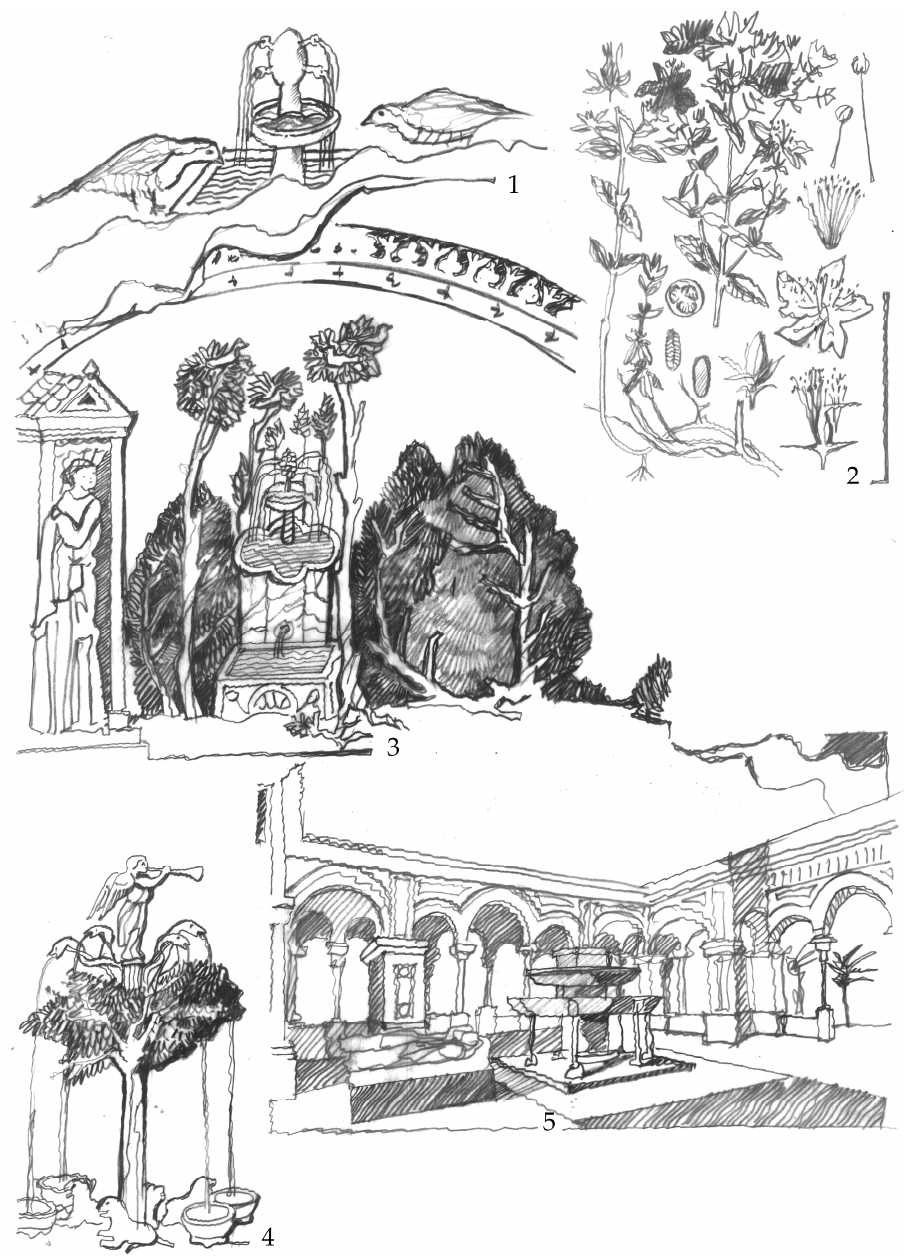
Figure 2. 1 and 3 —‘ Fountains… enclosed parts to irrigate’ ; 2 —‘ and out of Egypt the red St. John’s wort they brought ’; 4 — ‘ lions, leopards and eagles, partridges and fairies springing out of their mouths and wings clear water, ’; 5 —‘ a court of four entrances was built over the bridge… and inside a tomb there was ’ (sketches by the author).